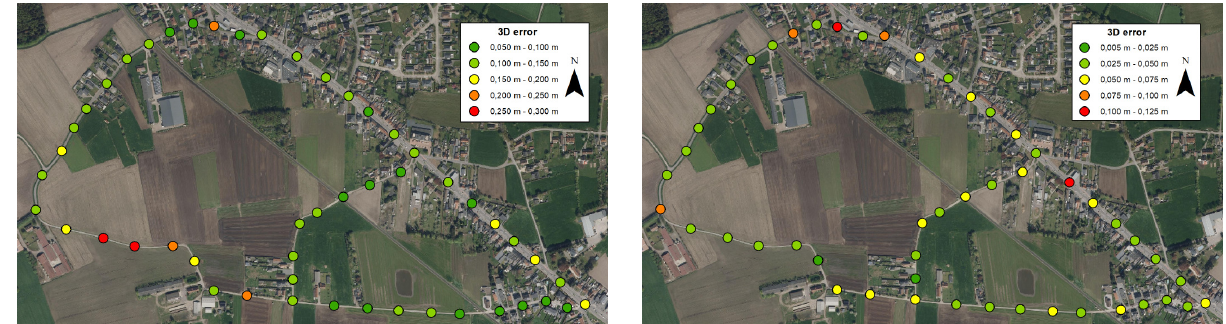
Figure 5. 3D errors of GCP in rural dataset for the low-end system (left) and high-end system (right).